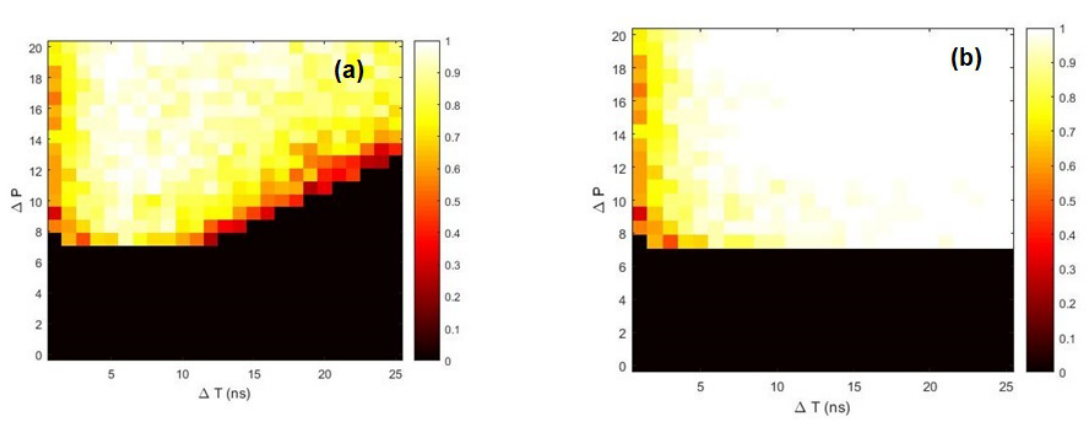
Figure 4. Success rate when the detection time interval is ∆ T det = 20 ns ( a ) and 100 ns ( b ). The parameters are P inj = 50 ns − 2 , µ = 2.064 and ∆ ν = − 2.589 GHz.